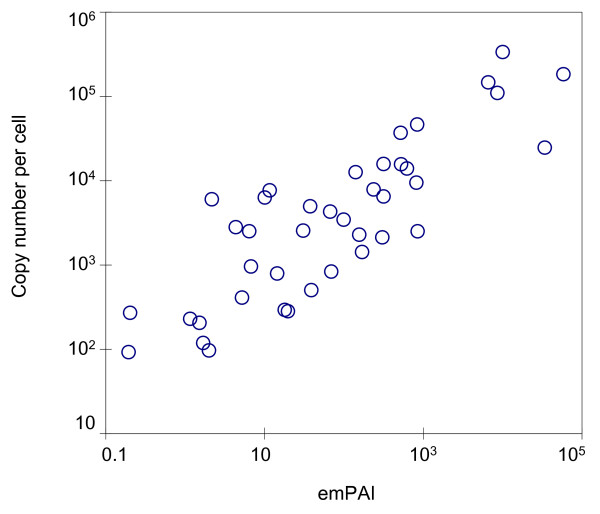
Correlation between observed emPAI values and independently measured protein copy numbers per cell. Protein abundances in the E. coli cytosol as measured by the emPAI approach correlate well with protein copy numbers per cell measured independently by isotope dilution using spiked E. coli BW25113 cells containing 40 proteins with known amounts [33]. A dynamic range of approximately 4 orders of magnitude of protein copy numbers per cell is covered. The Pearson correlation coefficient is 0.84 with a p-value < 10-10 for logarithmized and 0.52 (p-value < 10-4) for non-logarithmized variables.